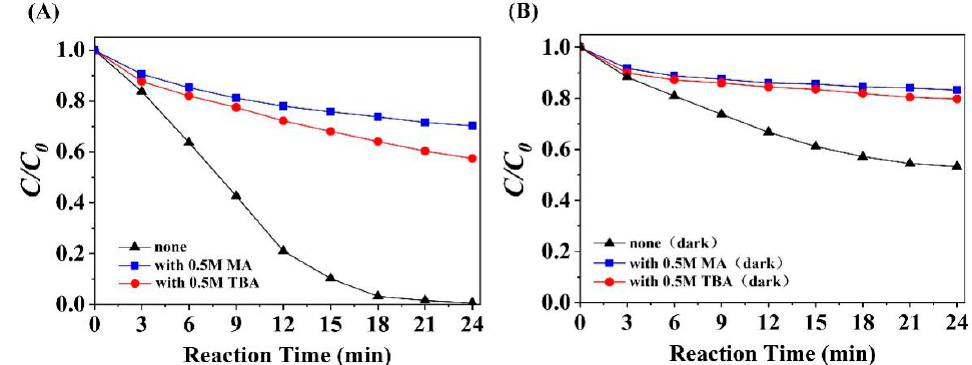
Figure 6. Effects of t-butanol (TBA) and methanol (MA) on azophloxine removal by the FeAlg-ACF/PMS system: ( A ) with light irradiation; ( B ) without light irradiation. Reaction conditions: [FeAlg-ACF] = 2 g/L, [PMS] = 5 mmol/L, [azophloxine] = 50 μ mol/L, initial pH = 6.0, T = 25 °C.